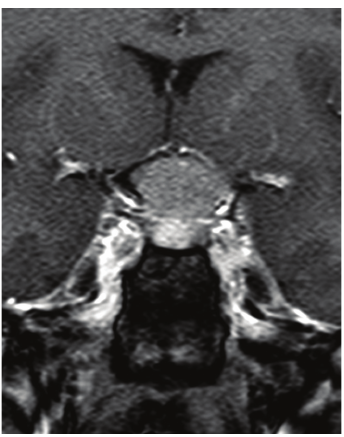
Figure 2: T1-weighted gadolinium-enhanced MRI revealed a tuber- culum sellae meningioma measuring approximately 1.7cm × 1.9cm × 1.3 cm.